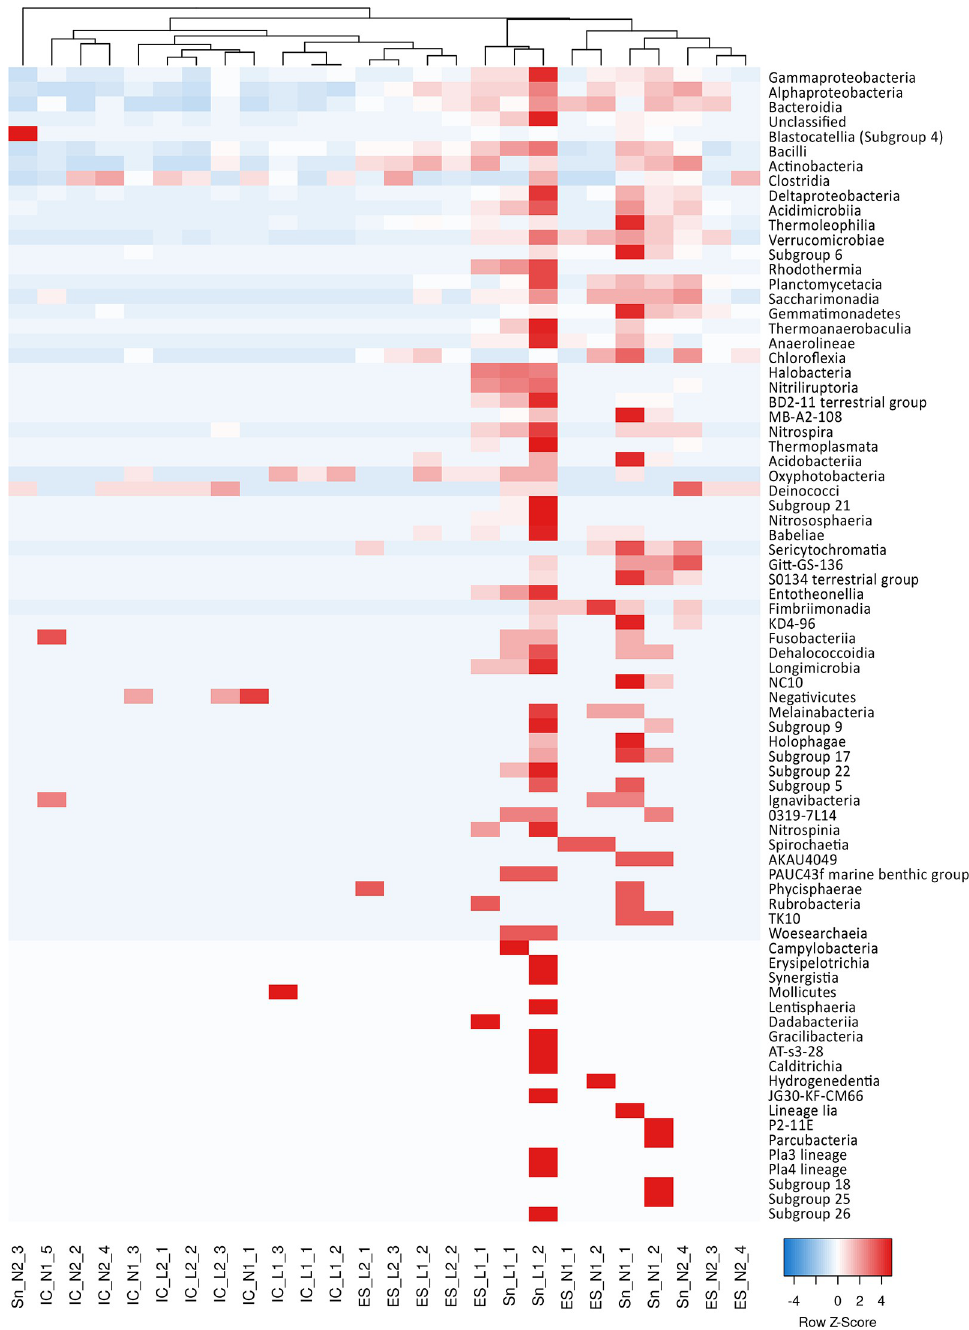
Fig 3. Heat Map based on the detected classes of all studied samples, generated by the “complete linkage” calculation and using Spearman Rank correlation. Promicromonosporaceae and Spirosomaceae in Campania nest 2 (Fig 4D). This result suggests specific microbial signatures on each beach, that could influence the microbial egg composition.